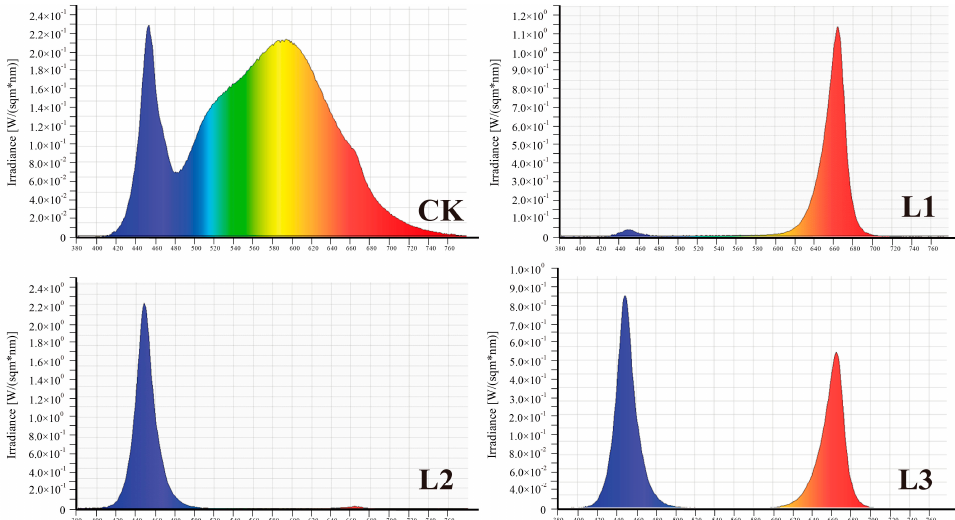
Figure 3. The relative spectral photon flux of AEpic LED-growth lamps in Room 2 of the blueberry plant factory. Notes: CK, white LED light; L1, red spectrum, L2, blue spectrum, L3, 60% red + 40% blue spectrum. The wavelengths of light sources were measured with a Spectro-Radiometer (JETI 1211, JETI Technische Instrumente GmbH, Jena,